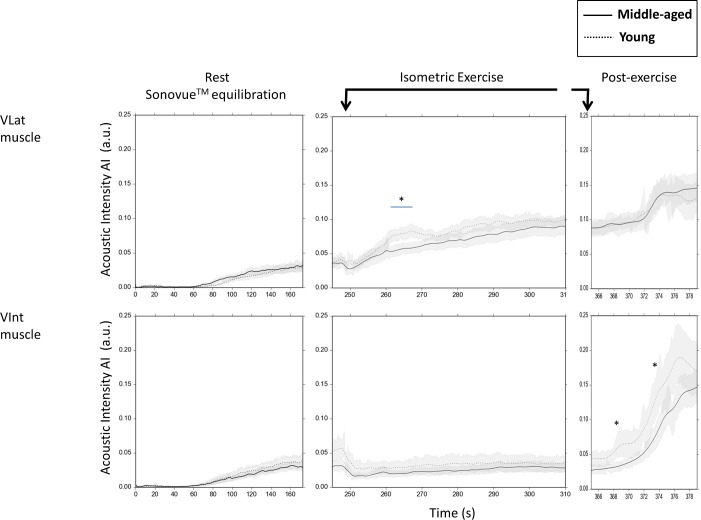
‘Time courses of the mean contrast-agent CEUS signals’.Time course of the mean (±SEM) Sonovue microbubble signal in the vastus lateralis (VLat; upper panel) and the vastus intermedius (VInt; lower panel) muscle region of interests (ROI) in middle-aged (MA, n = 15) and young (YG, n = 11) males in the experimental intervals: equilibration at rest (left; initial 180 s of Sonovue infusion), isometric exercise (middle; first 60 s of knee extension at 15% of PT), and post-exercise (right; initial 15 s after cessation of). Note the different time scales on the x-axis with these three conditions. The time intervals for repetitive Sonovue replenishment curve (RC) recording following high-MI US destruction of Sonovue microbubbles (See Fig 1) are presented separately in Fig 4A (mean RC curves) and Fig 4B (means of the individual regression lines obtained from individual RC curves). * for p<0.05 MA vs YG by unpaired Student’s t-test.